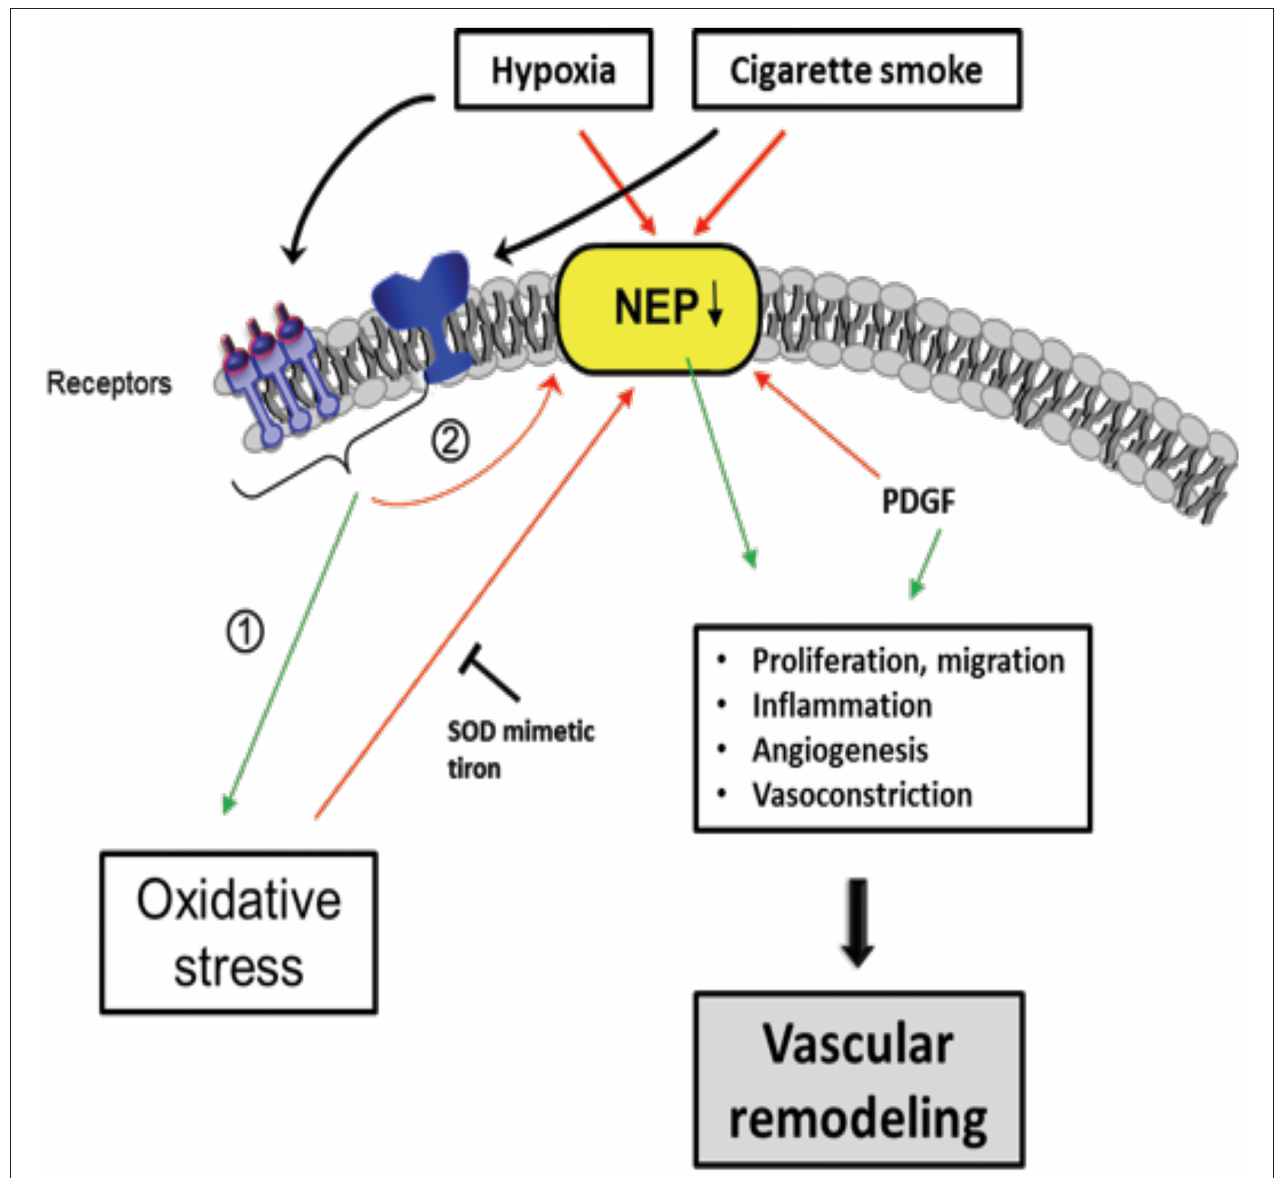
FIGURE 6 | Scheme of proposed Neprilysin (NEP)-dependent mechanisms leading to vascular remodeling. Extracellular stimuli, such as hypoxia and cigarette smoke activate pathways in vascular cells causing downregulation of NEP expression and/or activity which was seen in patients with COPD associated with PH. Stimuli can have direct negative effects on NEP, but also indirectly by (1) increasing ROS, PDGF and (2) activation of other pathways, in part receptor-mediated. NEP downregulation leads to elevated proliferation, migration, inflammation, Angiogenesis, and vasoconstriction mediated amongst others by depicted molecules causing vascular remodeling. The ROS effect on NEP can be inhibited by the superoxide dismutase (SOD) mimetic tiron. Colored boxes indicate involvement in the respective pathway; red arrows, inhibition/downregulation; green arrows, activation/upregulation; PDGF, platelet-derived growth factor; ET-1, endothelin-1; FGF-2, fibroblast growth factor; AT-II, angiotensin-II; PASMC, pulmonary artery smooth muscle cells; EC, endothelial cells; FB, fibroblasts.